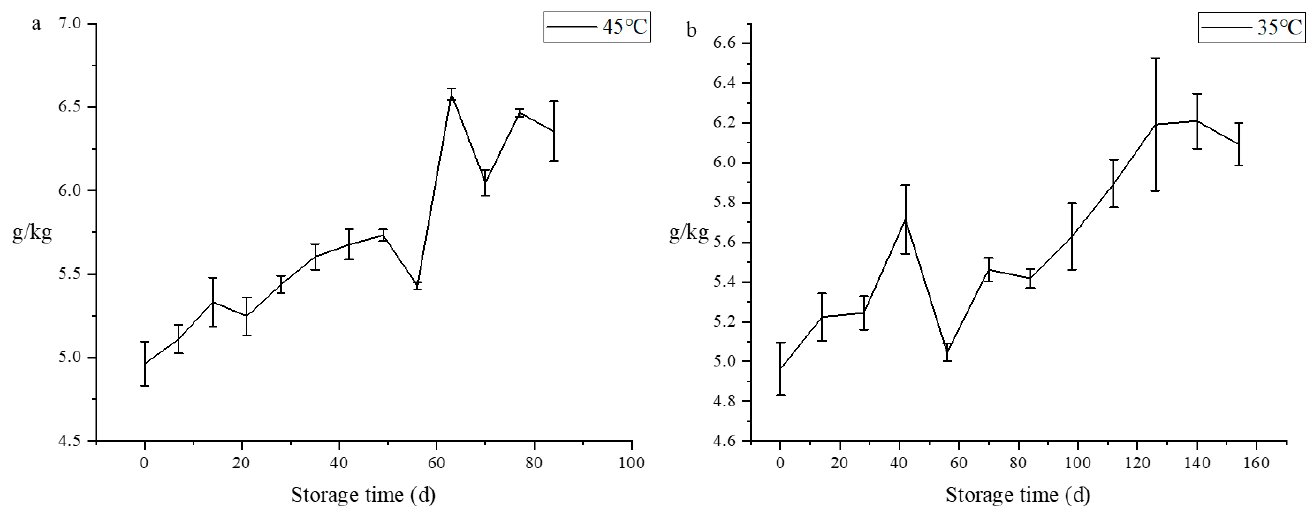
Figure 2. Changes of total acid in Sichuan sauerkraut during storage at different temperatures. (the temperature of a is 45 °C; the temperature of b is 35 °C.)